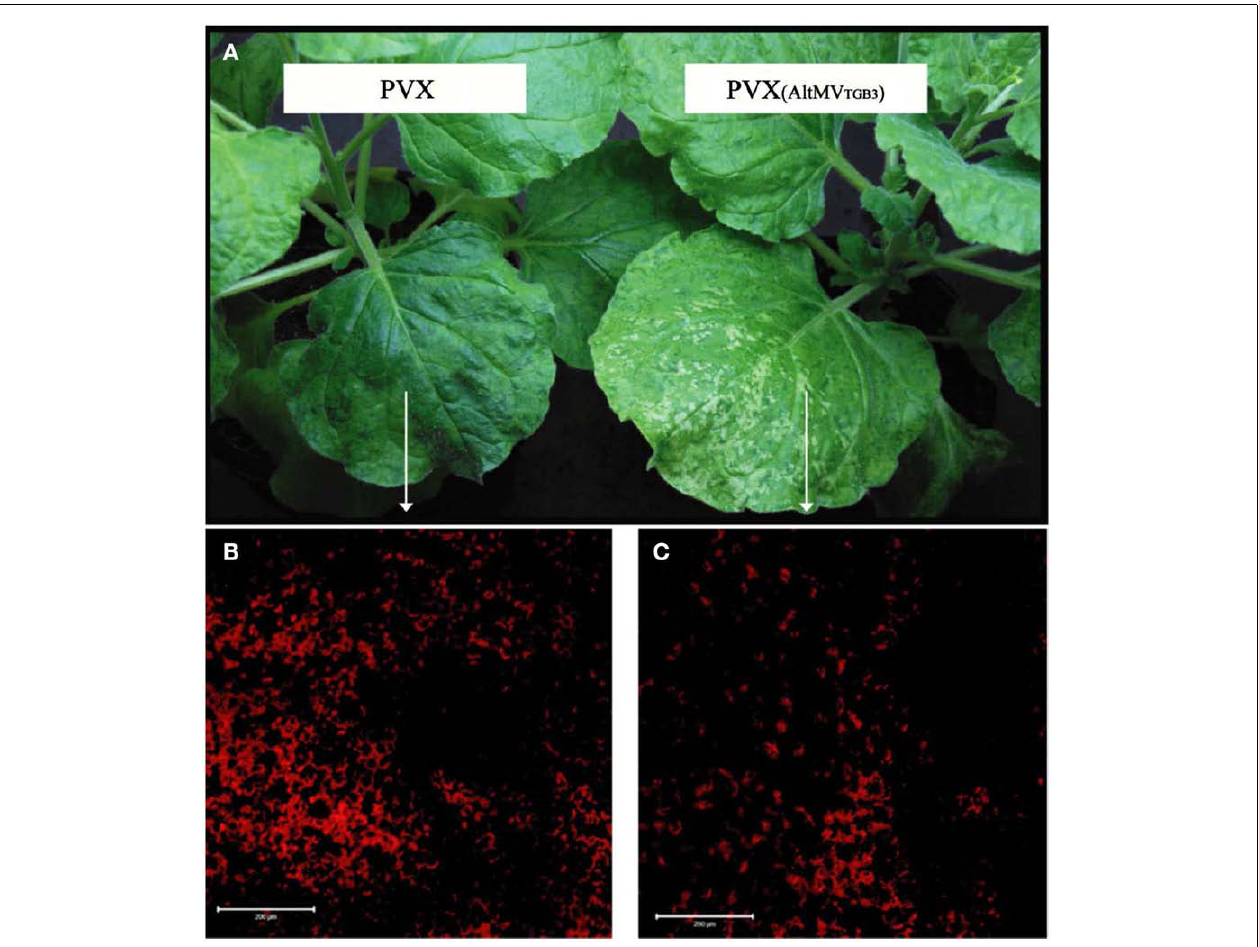
over-expressing AltMVTGB3 (right). (B) LSCM visualization of chloroplast autofluorescence in the mesophyll layer of indicated area of leaf infected with PVX. (C) Significantly reduced chloroplast autofluorescence in indicated region of leaf infected with PVX over-expressing AltMVTGB3. Scale bar = 200 µ